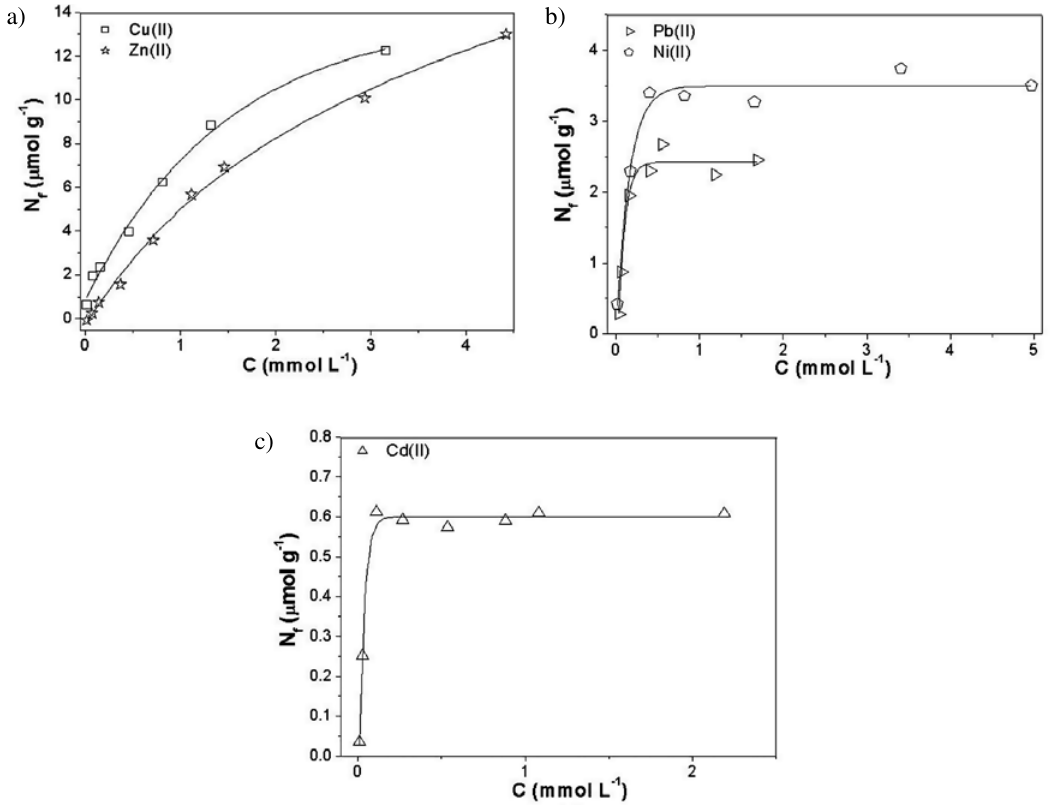
Figure 8. Adsorption of Cu(II) and Zn(II) (a), Pb(II) and Ni(II) (b), and for Cd(II) (c) as a function of the initial concentration for the